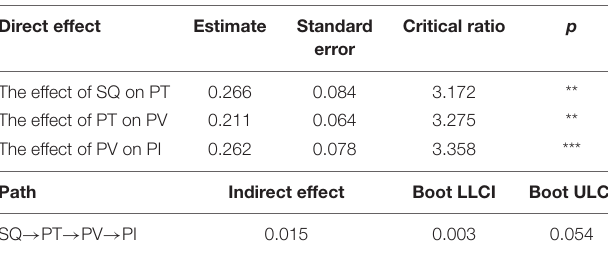
TABLE 9 | Results of path analysis